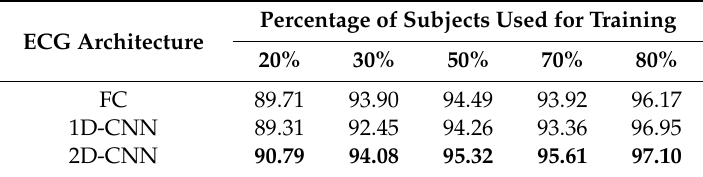
Table 6. Sensitivity analysis of the proposed architectures against the number of training subjects in terms of the reported testing accuracy (ACC